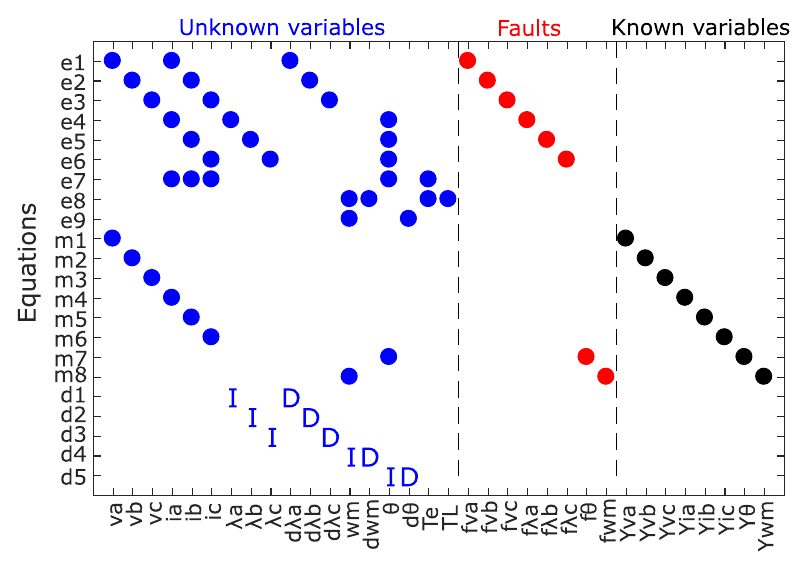
Figure 3. PMSM structural